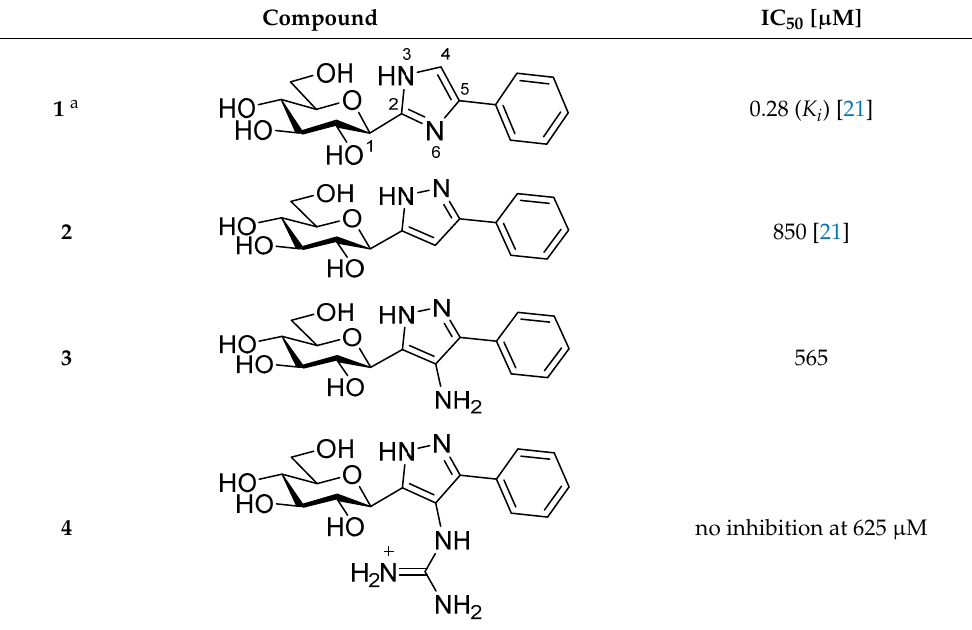
Table 1. Results from the binding assay experiments for the target compounds 3 and 4 against rabbit muscle glycogen phosphorylase b ( rm GPb). Reference compounds 1 and 2 are shown for comparison.